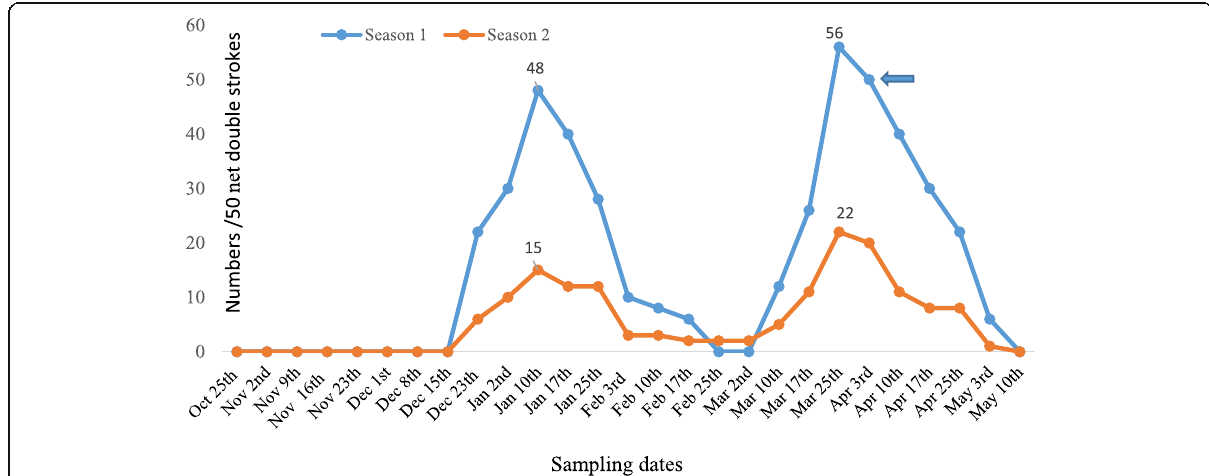
Fig. 1 Numbers of H. brunneipennis (EAW) larvae/50 net double strokes in season 1 (2016/2017) and season 2 (2017/2018) after applying B. bassiana in season 1